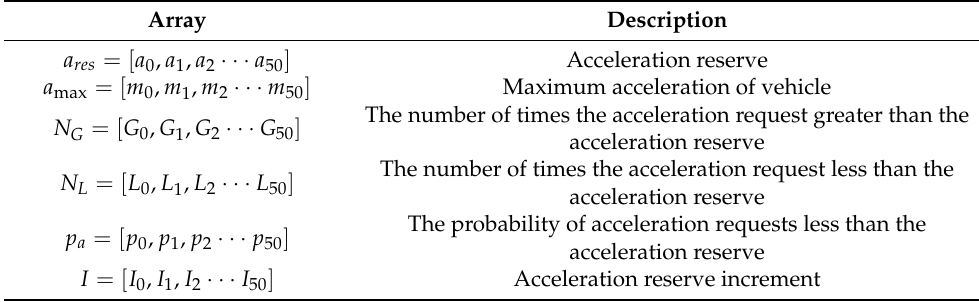
Table 2. Variable power reserve adaption process